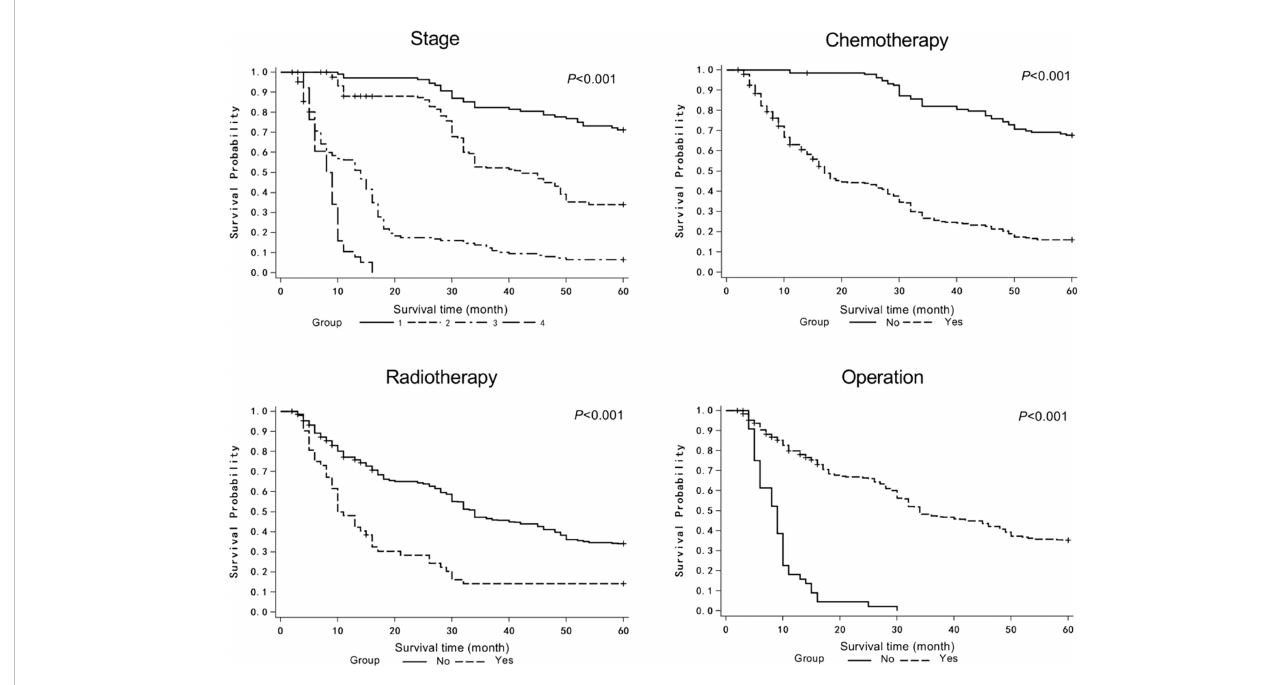
FIGURE 2 Survival curves for patients with lung